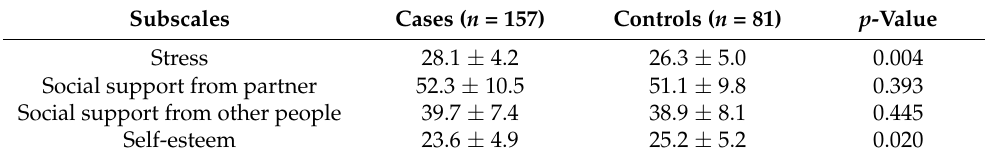
Table 6. PPP survey results between women with thrombophilia and recurrent pregnancy loss (cases), women with thrombophilia and recurrent pregnancy loss who achieved a normal pregnancy, and preterm or full-term birth